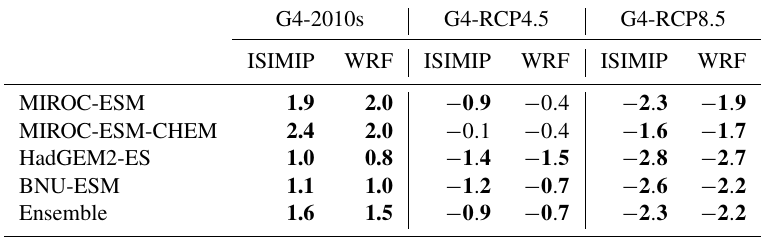
Table 3. Difference of 2m temperature between G4 and ERA5 in the 2010s and RCP scenarios in the 2060s for the high-resolution domain (Fig. 1). Bold indicates the differences or changes are significant at the 95% confidence level according to the Wilcoxon signed rank test (units: ◦ C).